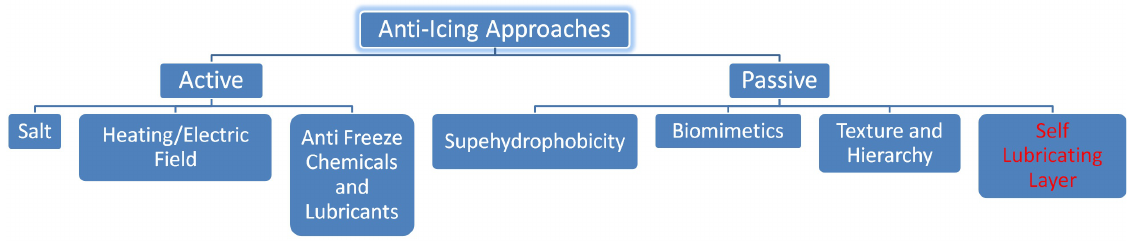
Figure 1. Schematic showing the major approaches towards anti-icing.